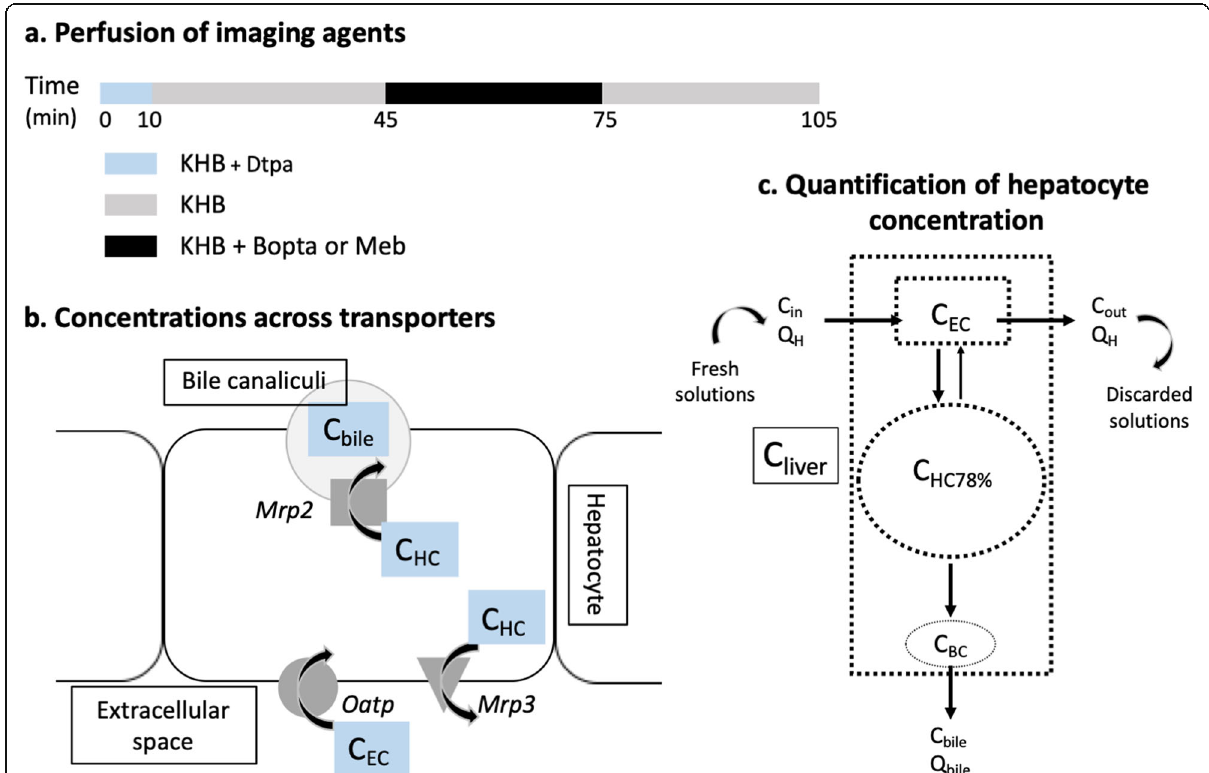
Fig. 1 a Perfusion of imaging agents. Livers ( n = 15) were successively perfused with Krebs-Henseleit bicarbonate solution (KHB) + 200 μ M 153 Gd- Dtpa, KHB, KHB + 200 μ M 153 Gd-Bopta, and KHB. Nine additional livers were perfused with KHB + 64 μ M 99m Tc-Dtpa, KHB, KHB + 64 μ M 99m Tc-Meb, and KHB. Illustration of Bopta and Meb transport across Oatp, Mrp2, and Mrp3 ( b ) and quantification of hepatocyte concentration ( c ). Extracellular concentration ( C EC ) is quantified during Dtpa perfusion. C HC78% for hepatocyte concentration measured by the counter. In situ concentration in bile canaliculi is similar to concentration in common bile duct ( C bile ). Bile canaliculi concentration measured by the counter ( C BC ) is C bile · 0.0043 (volume ratio of canaliculi to liver).